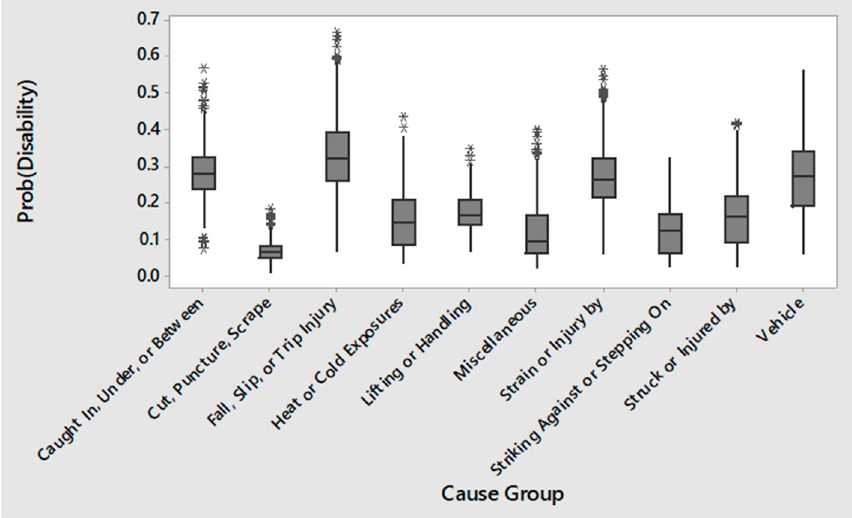
Figure 1. Boxplot of disability post-incident state for each cause group. (* shows the outlier data points). Table 5. Detailed estimates from the LR model.